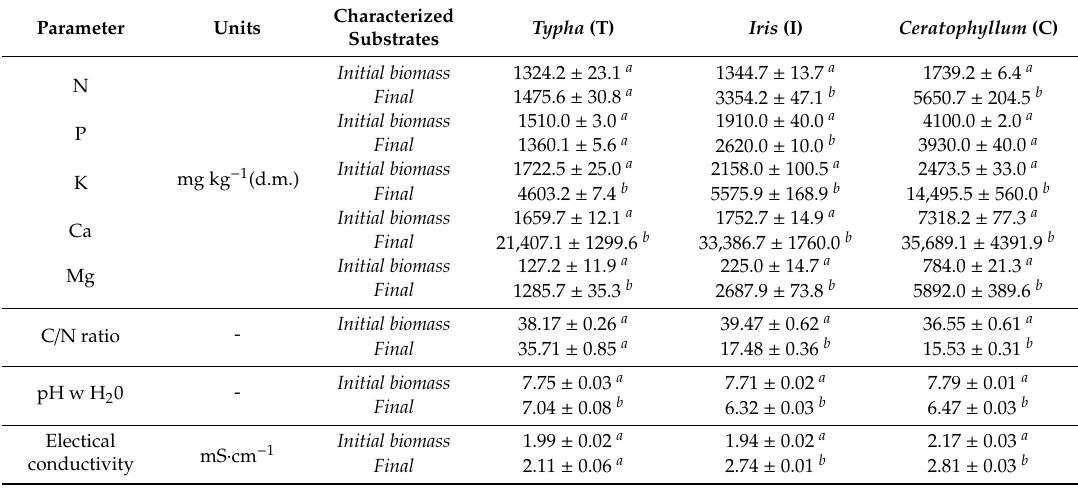
Table 1. Macroelement content in the biomass of littoral plant waste and the obtained vermicomposts.